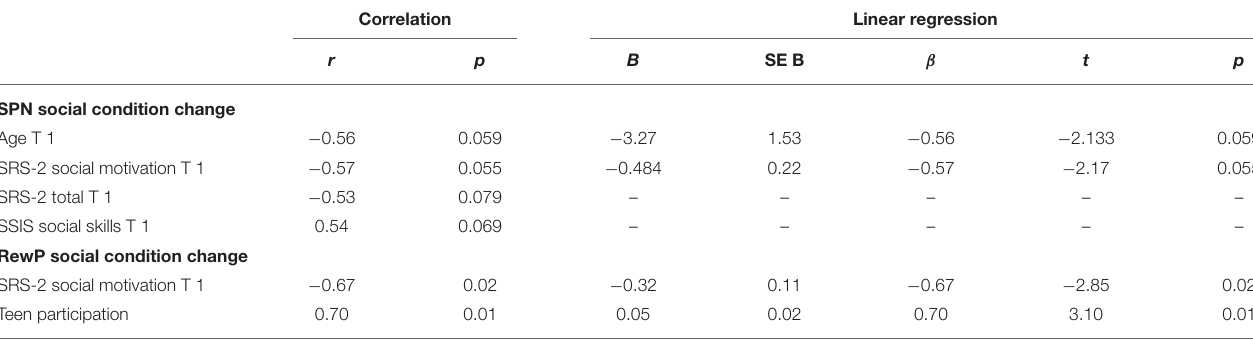
TABLE 3 | Results of correlations and linear regressions in the ASD Group only. Correlation Linear